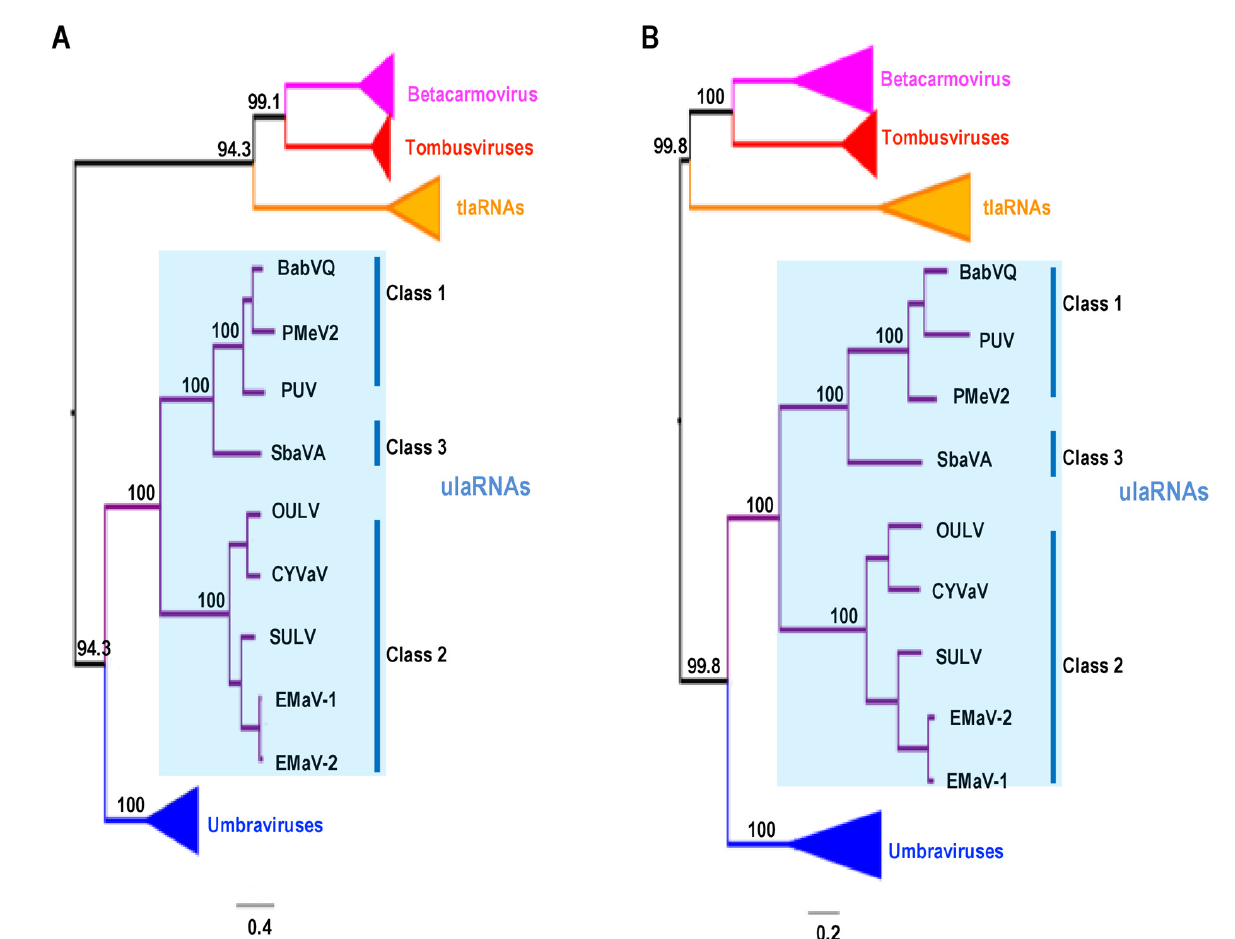
Figure 2. Maximum likelihood phylogenetic tree based on the amino acid ( A ) and nucleotide ( B ) sequence of RdRp from ulaRNAs, 6 tlaRNAs and 24 viruses from the umbravirus, tombusvirus and betacarmovirus genera. Branch numbers indicate bootstrap support in percentage out of 1000 replicates. The scale bar denotes nucleotide/protein substitutions per site. Both trees were mid-point rooted. BabVQ: babaco virus Q (MN648673); CMoV: carrot mottle virus (FJ188473); CMoMV: carrot mottle mimic virus (U57305); CYVaV: citrus yellow vein associated virus (JX101610) [21]; EMaV-1 and EMaV-2: Ethiopia maize-associated virus (MN715238, MF415880); ETBTV: Ethiopian tobacco bushy top virus (KJ918748); GRV: groundnut rosette virus (MG646923); IxYaV2: ixeridium yellow mottle associated virus 2 (KT946712); OPMV: opium poppy mosaic virus (EU151723); OULV: opuntia umbra-like virus (MH579715); PMeV2: papaya meleira virus 2 (KT921785); PUV: papaya umbra virus (KP165407); PMMoV: patrinia mild mottle virus (MH922775); PEMV2: pea enation mosaic virus 2 (U03563); RCUV: red clover umbravirus (MG596237, MG596235); SULV: sugarcane umbra-like virus (MN868593); strawberry associated virus A (MK211274); TBTV: tobacco bushy top virus (KX216407).